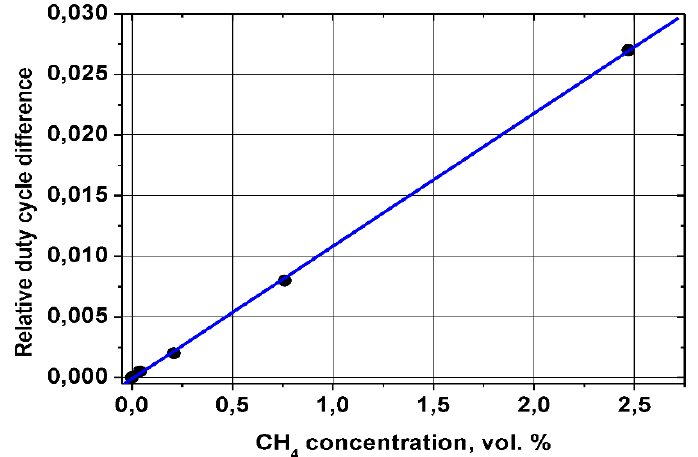
Figure 4. Response of thermocatalytic sensor to methane concentrations. Temperature of the sensing and reference elements of the sensor are stabilized independent of methane concentration in ambient air. The measured value (relative duty cycle difference) is a difference in power necessary to heat sensing and reference elements at various methane concentrations. This difference in power is measured as a difference in duty cycle of PWM temperature stabilization